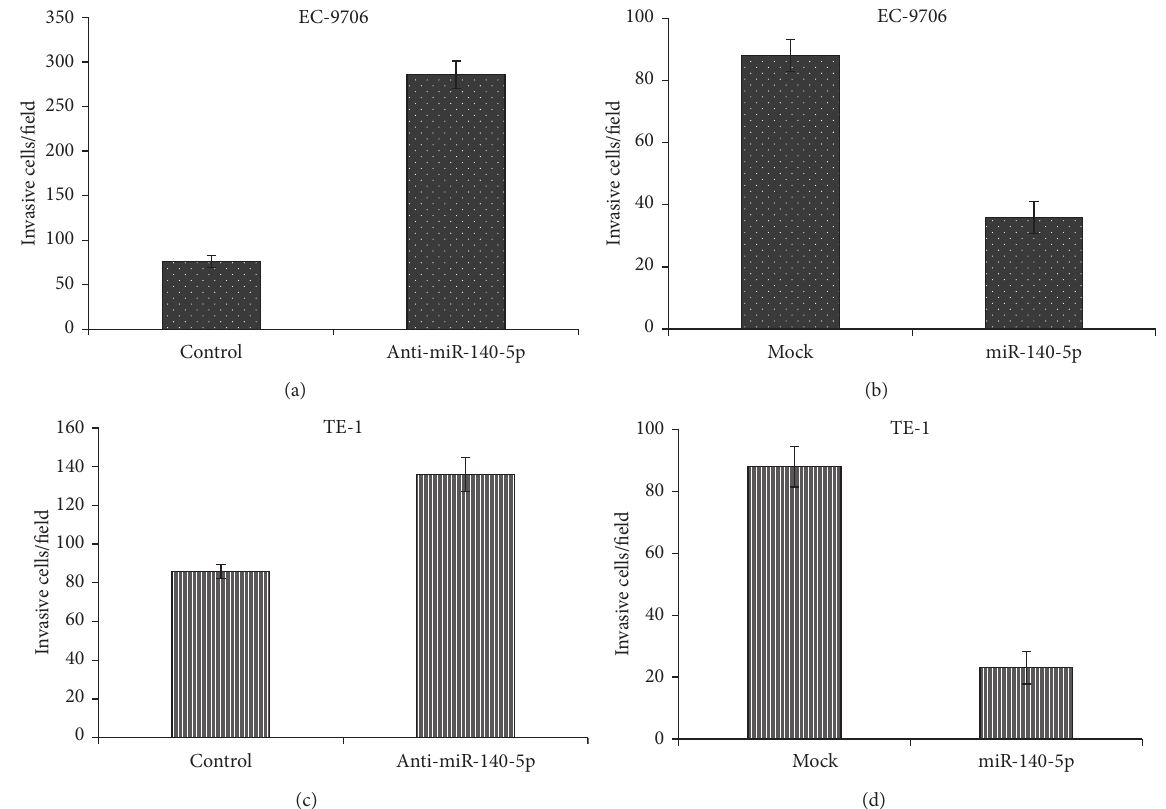
Figure 6: Effect of miR-140-5p on cell invasion of esophageal cancer cells. miR-140-5p and anti- miR-140-5p were transfected on EC9706 (a and b) and TE-1 (c and d) cells and cell invasion was analyzed using the transwell invasion